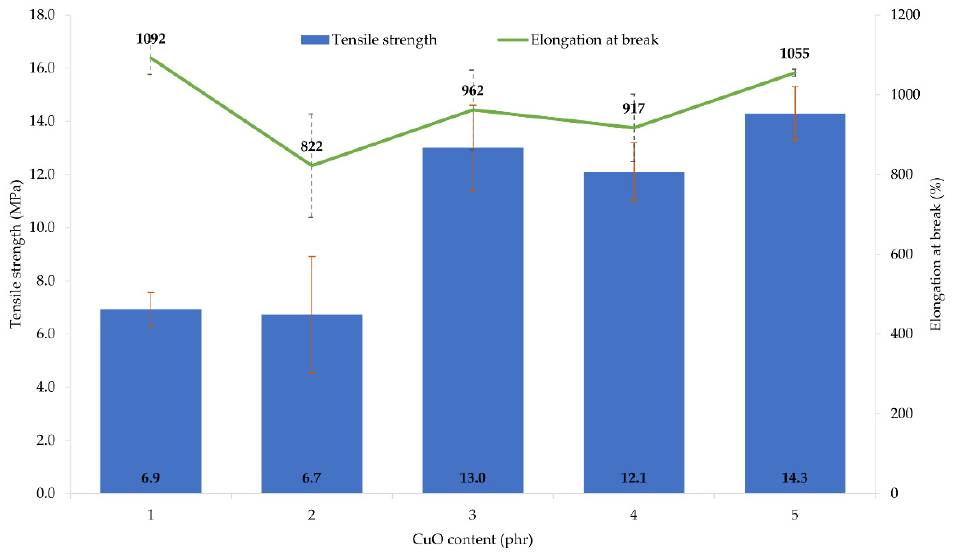
T = 160 ◦ C, t = 45 CuO); T = 160 °C, t = 45 min.